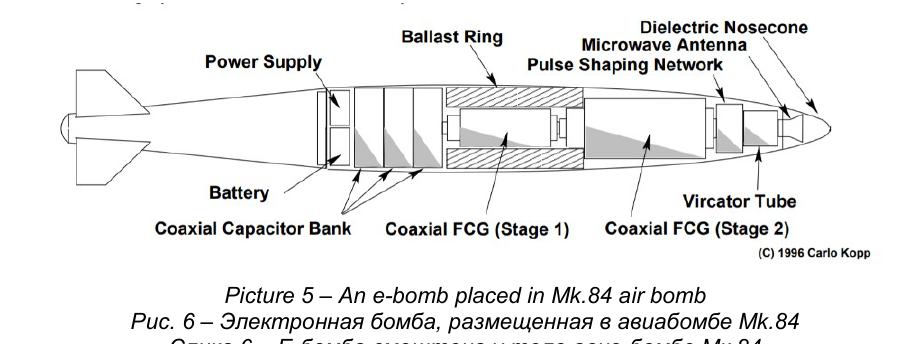
Рис. 6 – Электронная бомба, размещенная в авиабомбе